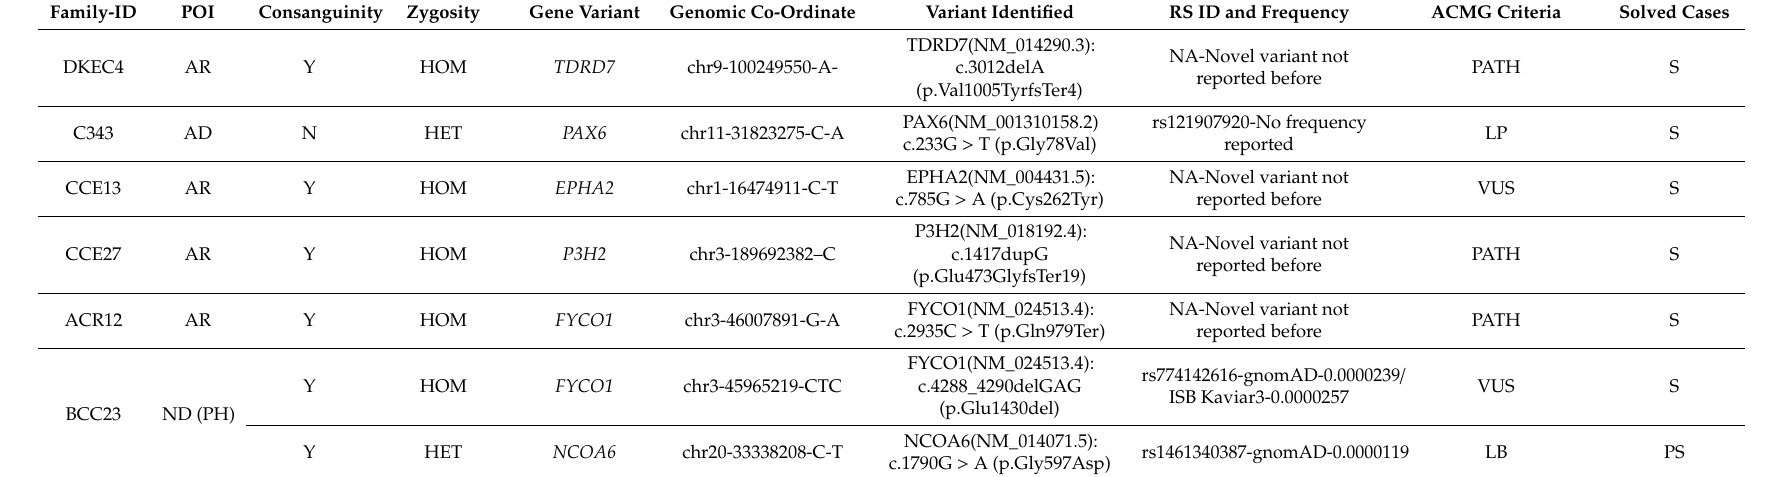
Table 2. Summary of the genetic findings in in resolved Congenital cataract